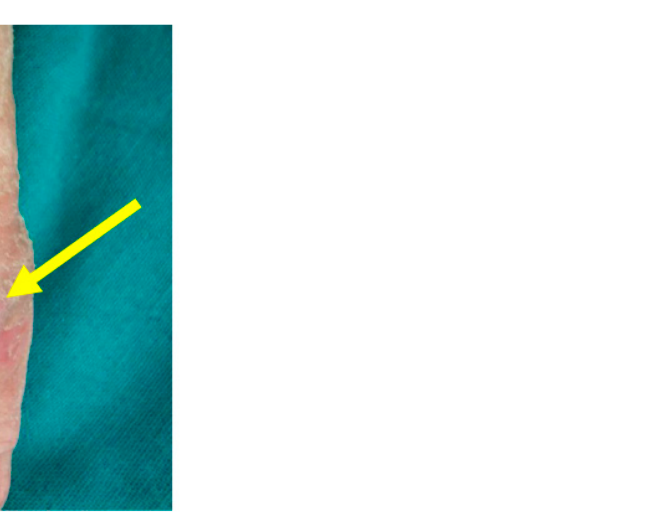
Figure 6. Radiographs showing fracture of the distal tibia metaphysis (pointed by the arrow) during Ponseti serial casting.